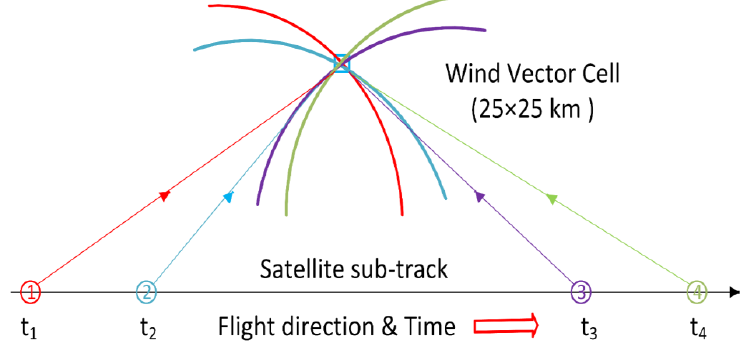
Figure 2. Time sequence of QuikSCAT measuring 4-flavor radar backscatter at one wind vector cell location. Each arc represents a portion of conical scan series of